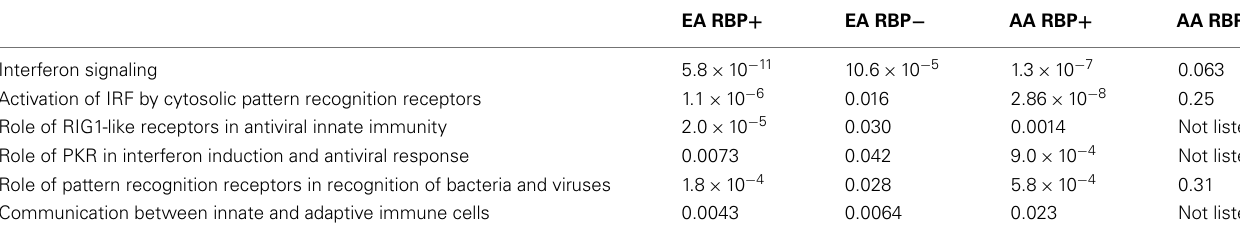
Table 4 | P values from IPA IFN-related canonical pathways from microarray